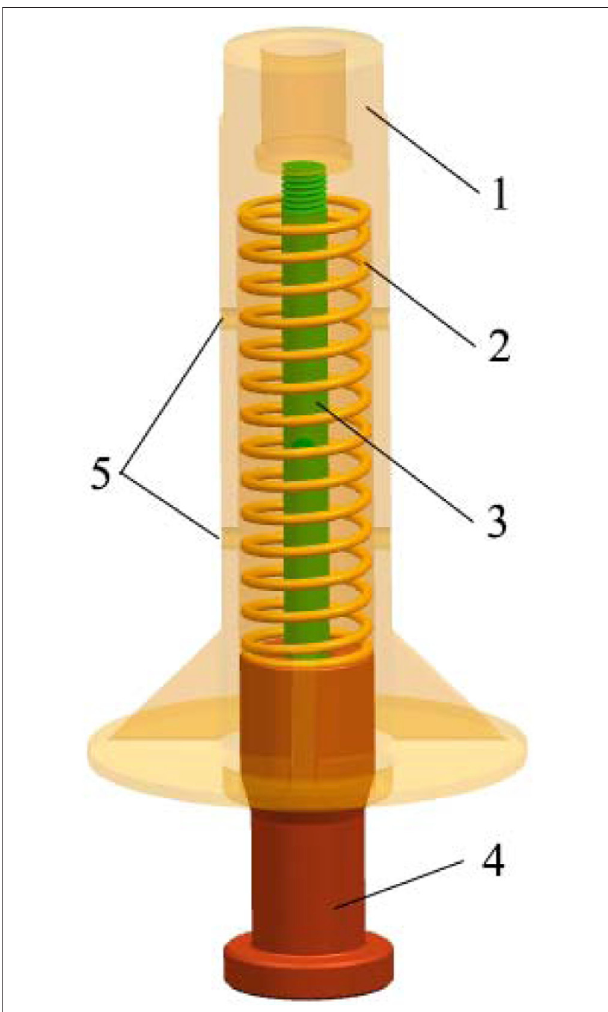
FIGURE 1 | Working principle diagram of the spider hydraulic buffer. (1- Spider body, 2-spring, 3-center pole, 4-piston body, 5-drain holes).